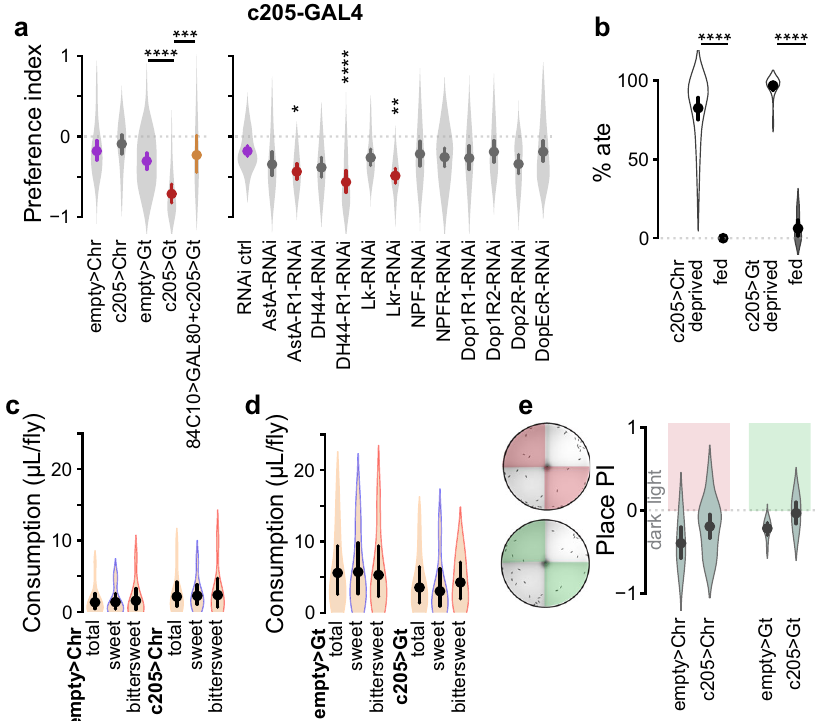
Fig. 3 Fan-shaped Body layer 6 is the convergence node of a decision making ensemble. a (left) Optogenetic activation of FBl6 neurons did not affect preference. In contrast, optogenetic inhibition shifted preference towards bittersweet. Simultaneous repression of GAL4 expression in FBl6 neurons using GAL80 during optogenetic inhibition abolished the preference shift induced by optogenetic inhibition. This manipulation con fi rmed the role of FBl6 neurons in producing preference shift upon optogenetic inhibition. a (right) RNAi knockdown of AstA-R1, DH44-R1, or Lkr receptors in FBl6 shifted preference toward bittersweet. b Optogenetic activation or inhibition of FBl6 did not induce feeding in fed fl ies or prevent feeding in food-deprived fl ies. Optogenetic activation ( c ) or inhibition ( d ) of FBl6 did not change total food consumption per fl y compared to respective empty-GAL4 controls. Food consumption was quanti fi ed by extracting red and blue food dyes from fl ies after the assay and measuring the extract absorbance using UV – vis spectrometry. Concentrations of individual dyes were calculated per trial by interpolating absorbance in the standard curve for each dye. Total volume of agarose ingested was then calculated from red and blue dye concentrations and divided by number of fl ies that ate red and blue food in that trial. Total food volume is the average of consumption by each fl y regardless of type of food consumed. Within each group, there was no signi fi cant difference in sweet vs. bittersweet